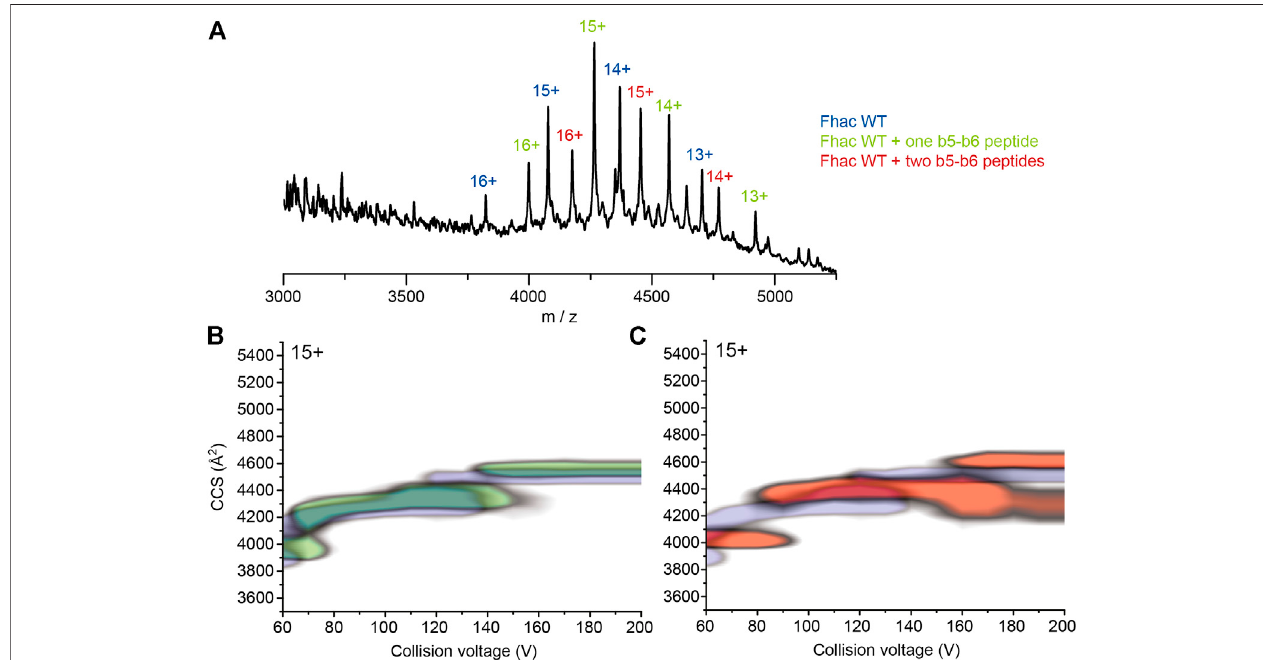
FIGURE 6 | Binding of synthetic peptides to FhaC. (A) Mass spectrum of FhaC alone or incubated with the b5-b6 peptide in conditions of high activation energy (CE = 150 V). The ionization state of the protein is indicated above each peak. The species indicated in blue correspond to FhaC alone, those in green correspond to FhaC withonepeptidebound, and thoseinred toFhaC withtwopeptides bound. (B) Overlay oftheCIUplotsofFhaCwith(green)and without(blue)oneb5-b6 peptide bound. Increased CCS values are observed both under native conditions (low CE) and conditions in which the POTRA domains are most likely unfolded (high CE). (C) Comparison of the CIU plots of FhaC alone (blue) and FhaC with two b5-b6 peptides bound (orange), which shows an additional CCS increase compared to FhaC with a single peptide